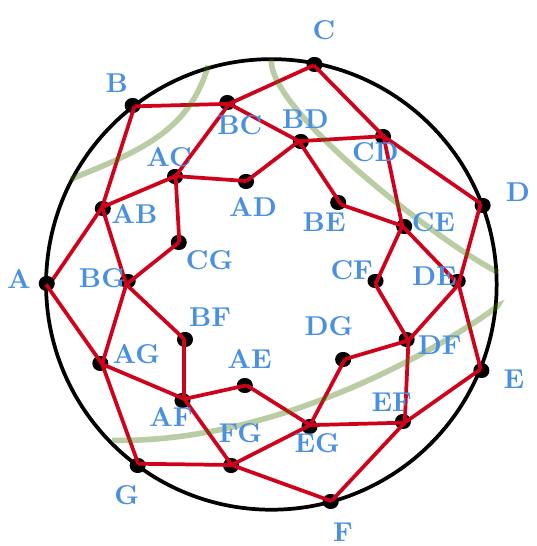
Figure 11 . The diamondwork construction for N = 7 atomic regions, placed on a circular bound- ary. The same min-cuts as in figure 10 are